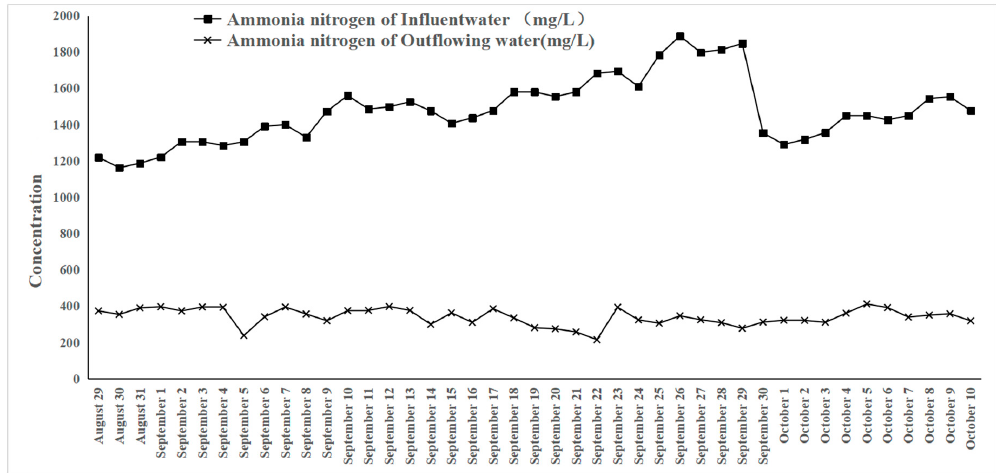
Figure 7. COD concentration change in the SBR reactor.